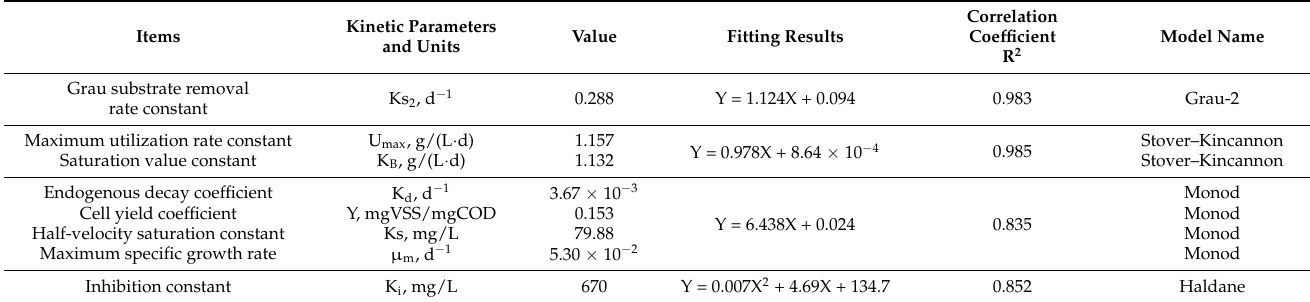
Table 4. The calculated kinetic parameters of anaerobic fermentation reaction in this